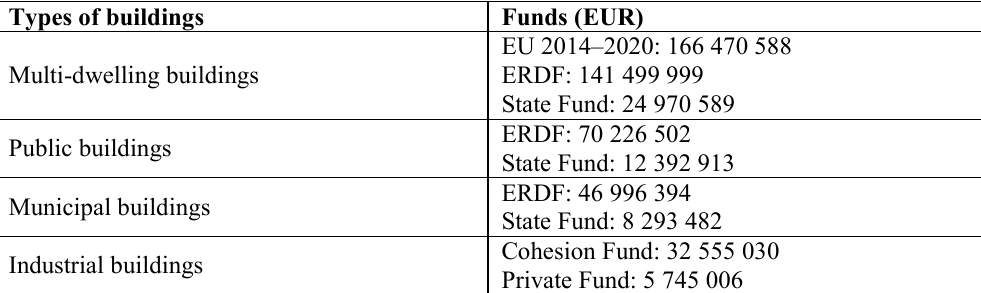
Table 7. Renovation Costs and